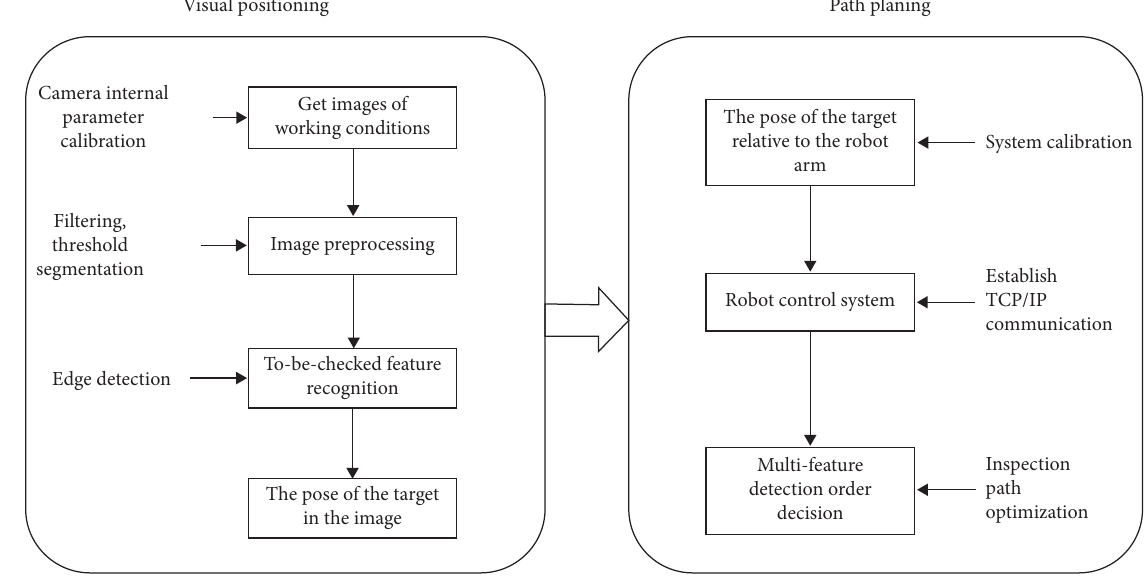
Figure 12: Software module flowchart.